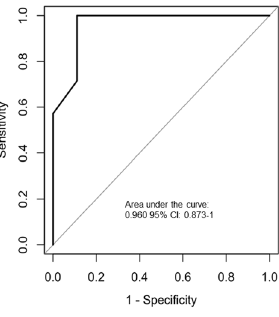
Figure 2. ROC curve of cotton thread test for detecting DED in pediatric patients after HSCT. For the usual cut-off value of 10 mm or less, the sensitivity was 0.71 (95% CI: 0.38–1.00), and the specificity was 0.89 (95% CI: 0.68–1.00), but the cut-off value giving the best balance between sensitivity and specificity was 17 mm with the sensitivity of 0.94 (95% CI: 0.77–1.00), and the specificity of 0.85 (95% CI: